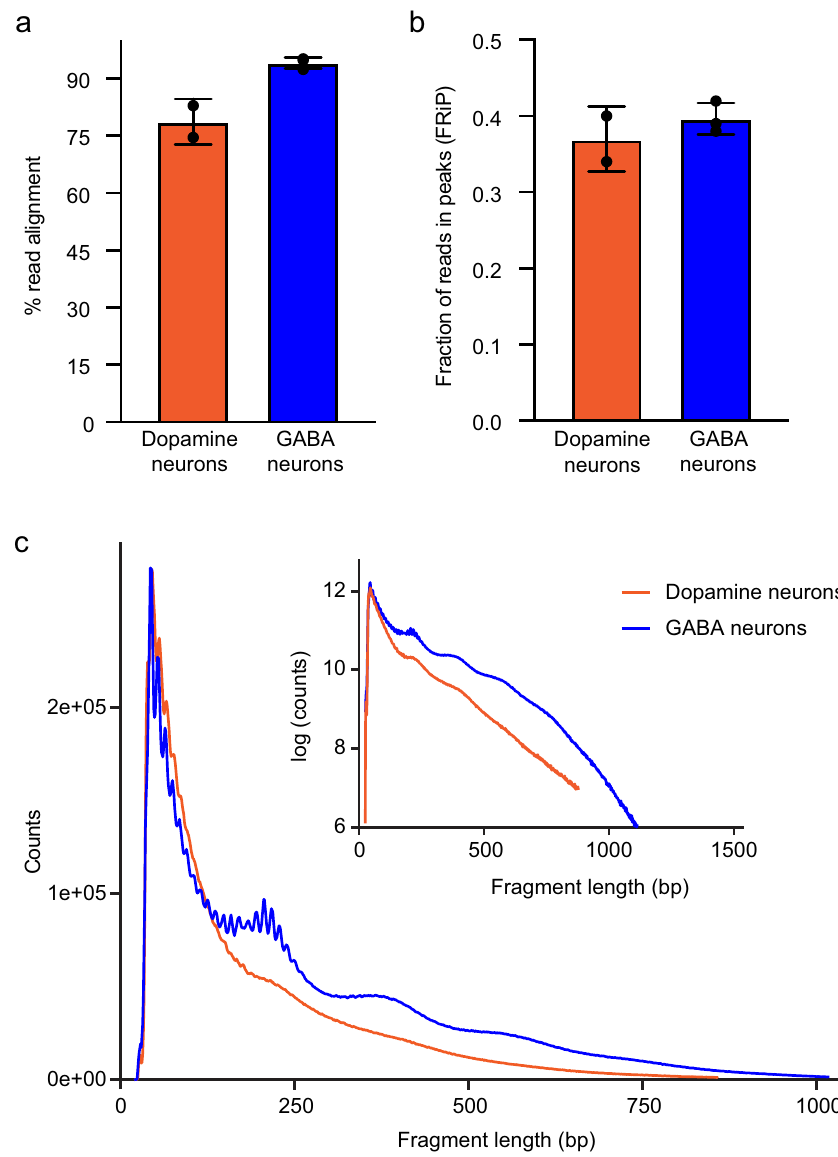
Figure 6. Optimized ATAC-seq parameters generate consistent libraries. Representative traces from ATAC- seq libraries prepared from dopaminergic and GABAergic nuclei isolated from adult Drosophila heads. The libraries were prepared using GFP+ nuclei from TH - Gal4 (dopamine) and vGAT - Gal4 (GABA) flies using our optimized protocol. ( a ) Fraction of reads uniquely aligned to the nuclear genome. The alignment rates were not significantly different between libraries prepared from dopaminergic and GABAergic neurons ( p = 0.2). ( b ) Fraction of reads in peaks (FRiP) after alignment, filtering, and peak calling. The FRiP values were not significantly different between the libraries ( p = 0.8). ( c ) Insert size distribution showing the expected nucleosomal periodicity. Inset: Log-scaled insert size distribution. In ( a ) and ( b ), the data represent the mean ± SD of at least two replicates per neuron type. Statistical differences were analyzed using Mann–Whitney U